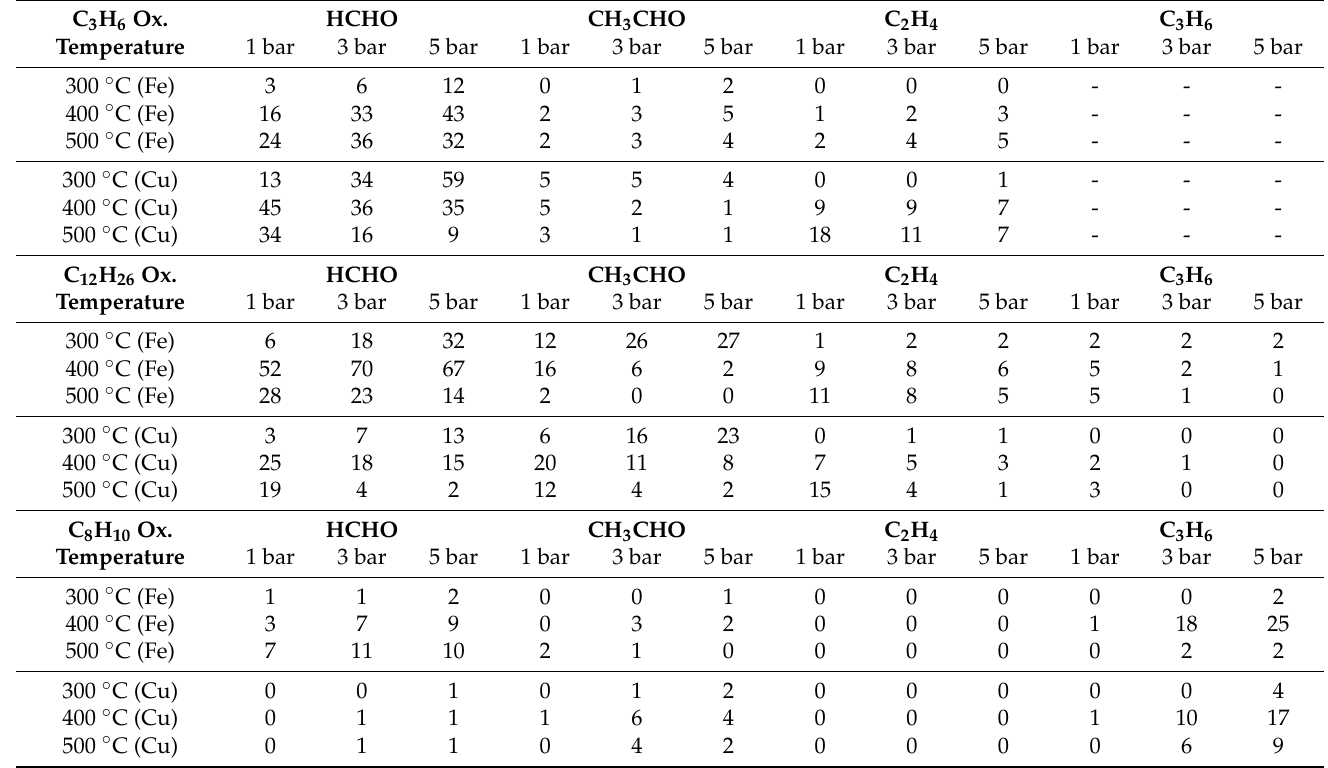
Table 1. Overview table of minor carbonaceous emissions during C 3 H 6 /C 12 H 26 /C 8 H 10 oxidation at 1, 3 and 5 bar pressure over Fe-ZSM-5 (Fe) and Cu-SSZ-13